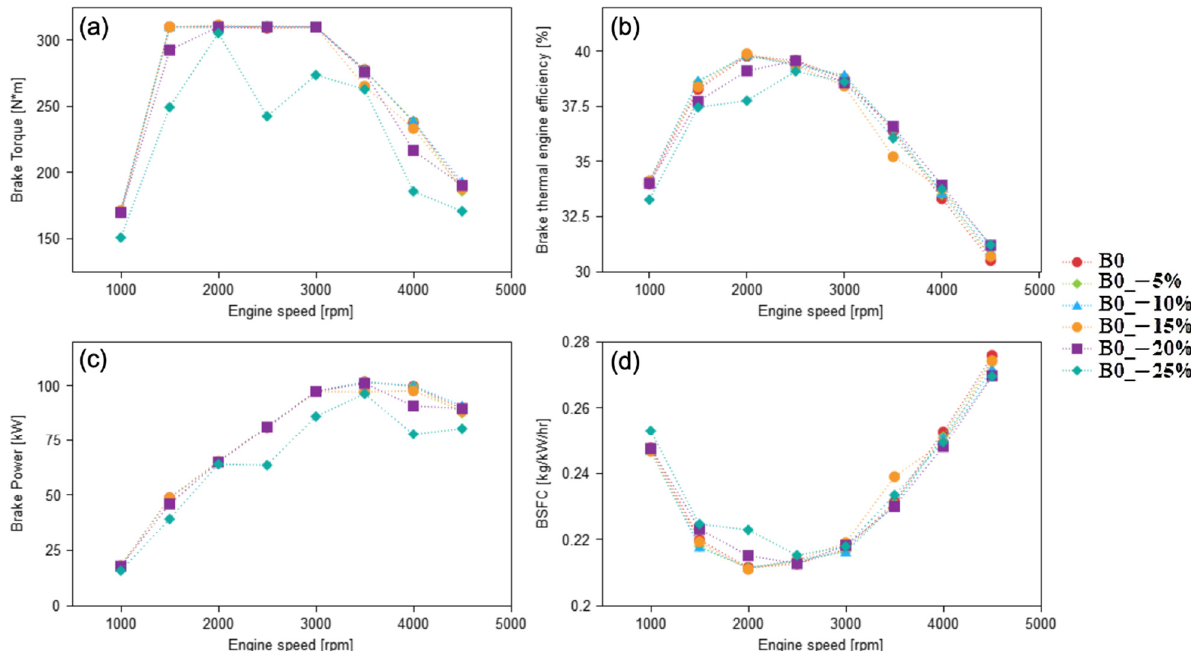
Figure 7. Comparison of ( a ) brake torque, ( b ) BTE, ( c ) brake power and ( d ) BSFC, for B0 EIVC operation. Table 4. The effect of the Miller cycle including both Eivc and Livc on the performance and emissions of a pure diesel engine at the rated speed, 3500 rpm (differences in % to the baseline without Miller cycle).